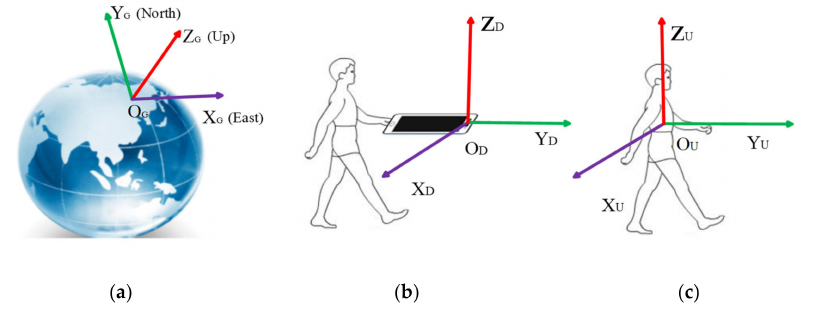
Figure 2. Illustration of the defined coordinate systems, ( a ) the local Cartesian coordinates coordinate system, ( b ) the device coordinate system, ( c ) the user coordinate